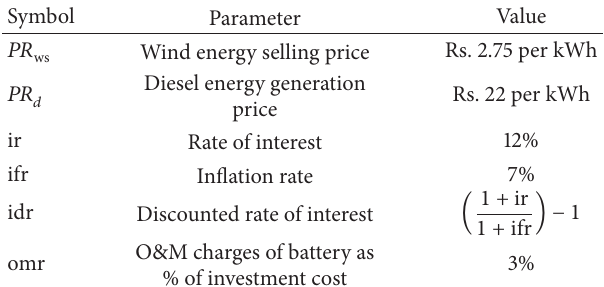
Figure 7: Solar irradiance and temperature in 24